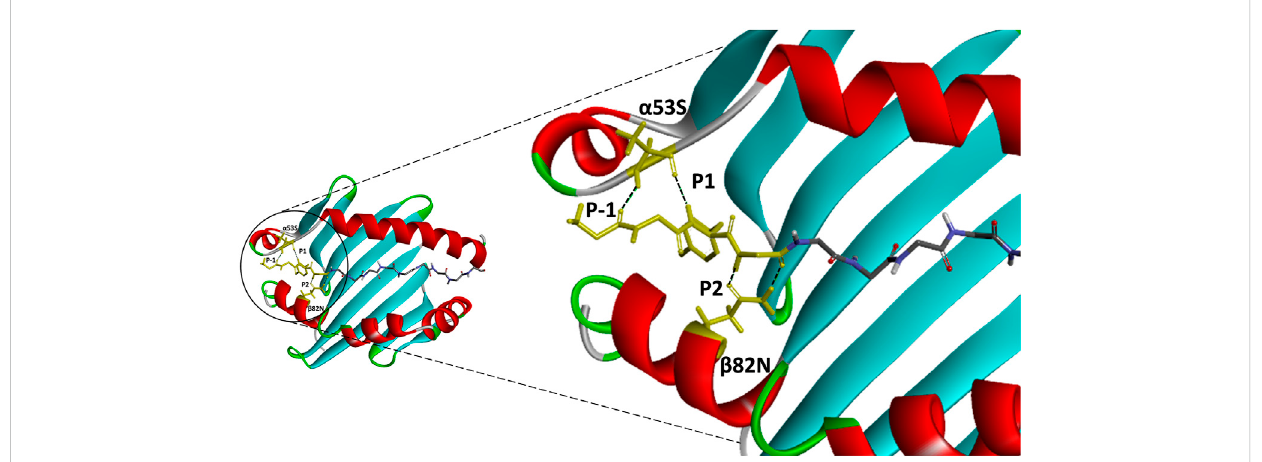
FIGURE 3 An atomic resolution of HLA-DR1:HA complex derived from PDB crystal structure (PDB:1HXY) with annotated critical intermolecular interactions between peptide ligand and the side chains of MHCII. Peptide backbone that formed conserved hydrogen bonds with MHCII residues ( α 53S and β 82N) were denoted as P-1, P1 and P2 anchor residues and highlighted in yellow.